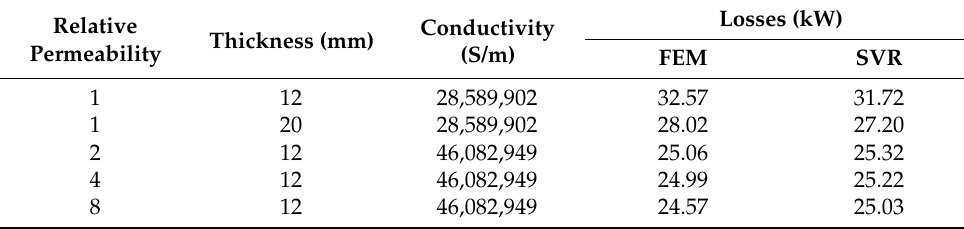
Table 5. Predictive eddy current losses in the test sample based on SVR.